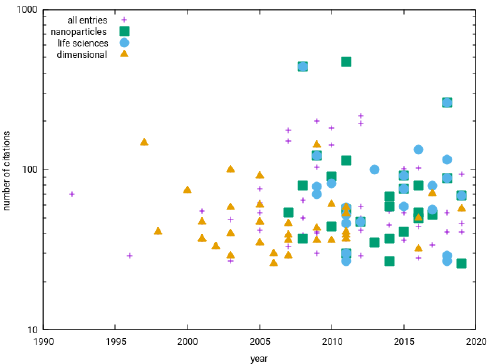
Figure 1. Temporal evolution of topics of the most cited 10% of papers with the subject